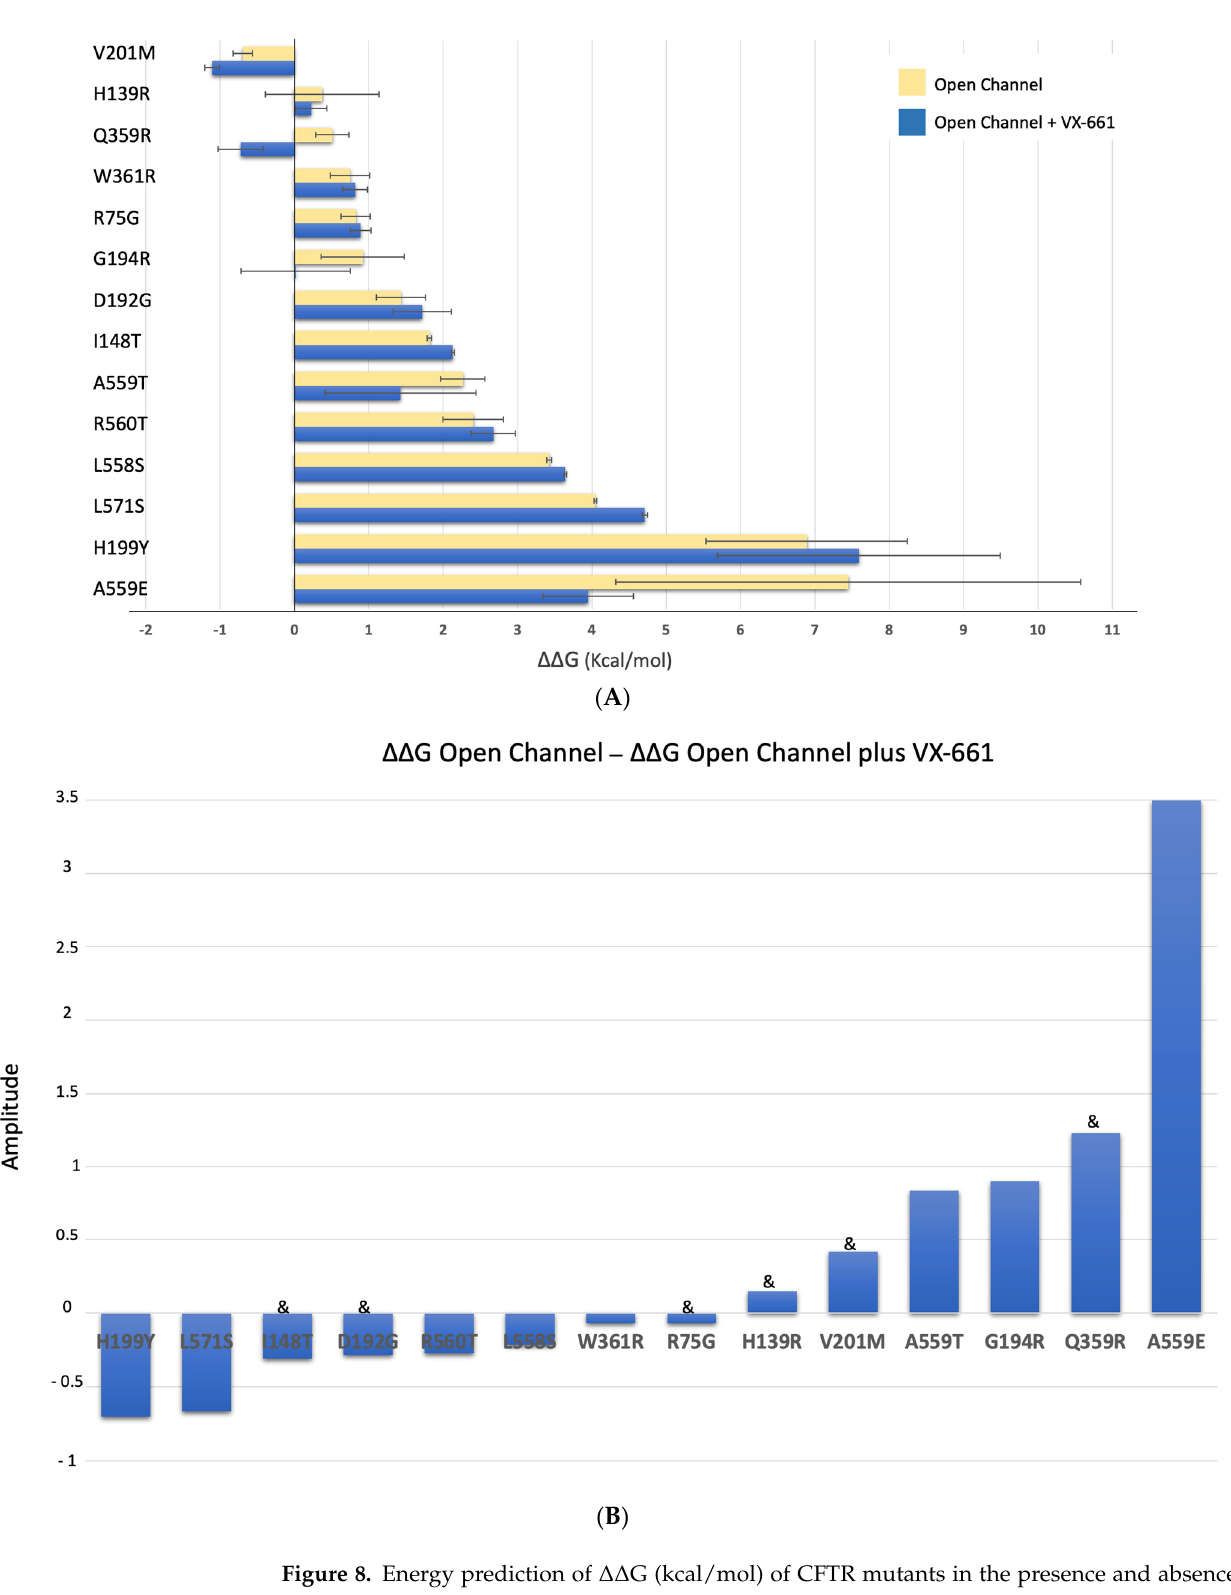
Figure 8. Energy prediction of ∆∆ G (kcal/mol) of CFTR mutants in the presence and absence of VX-661 calculated with FoldX [29]. ( A )—yellow bars: human CFTR bound to phosphorylated ATP (6msm)—“open” conformation [28] (similar to Figure 6A); blue bars: human CFTR + Mg/ATP + VX-661 (pdb:7sv7) [22]; bars are presented as mean ± standard deviation. ( B )—Variation of ∆∆ G (kcal/mol) for CFTR variants calculated as the difference between the ∆∆ G “open” and the ∆∆ G “open” in the presence of VX-661. “&” corresponds to variants in which band C is present.